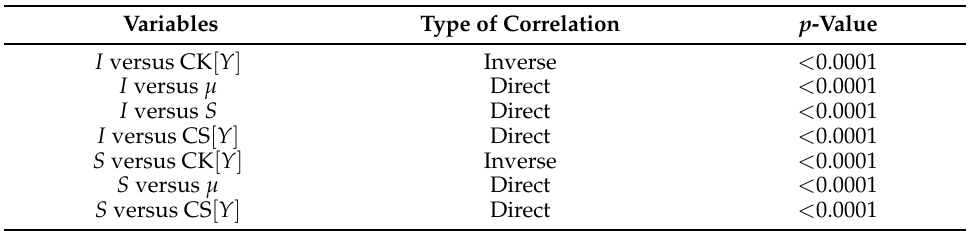
Table 7. Extract of correlations of interest for the simulation study according to their significance given by its p -value.